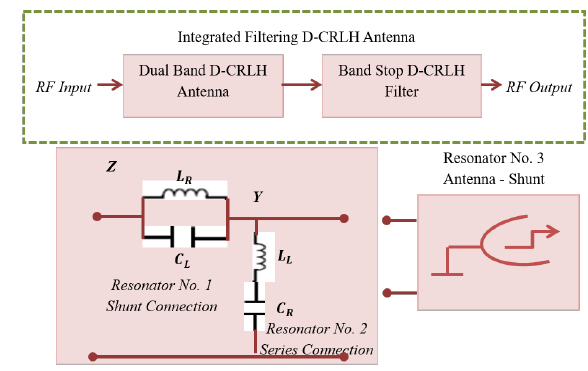
Fig. 3. The integration process of an “antenna” with a bandpass filter - unit